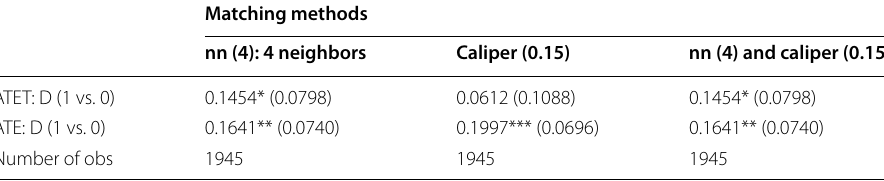
Table 3 PSM estimation